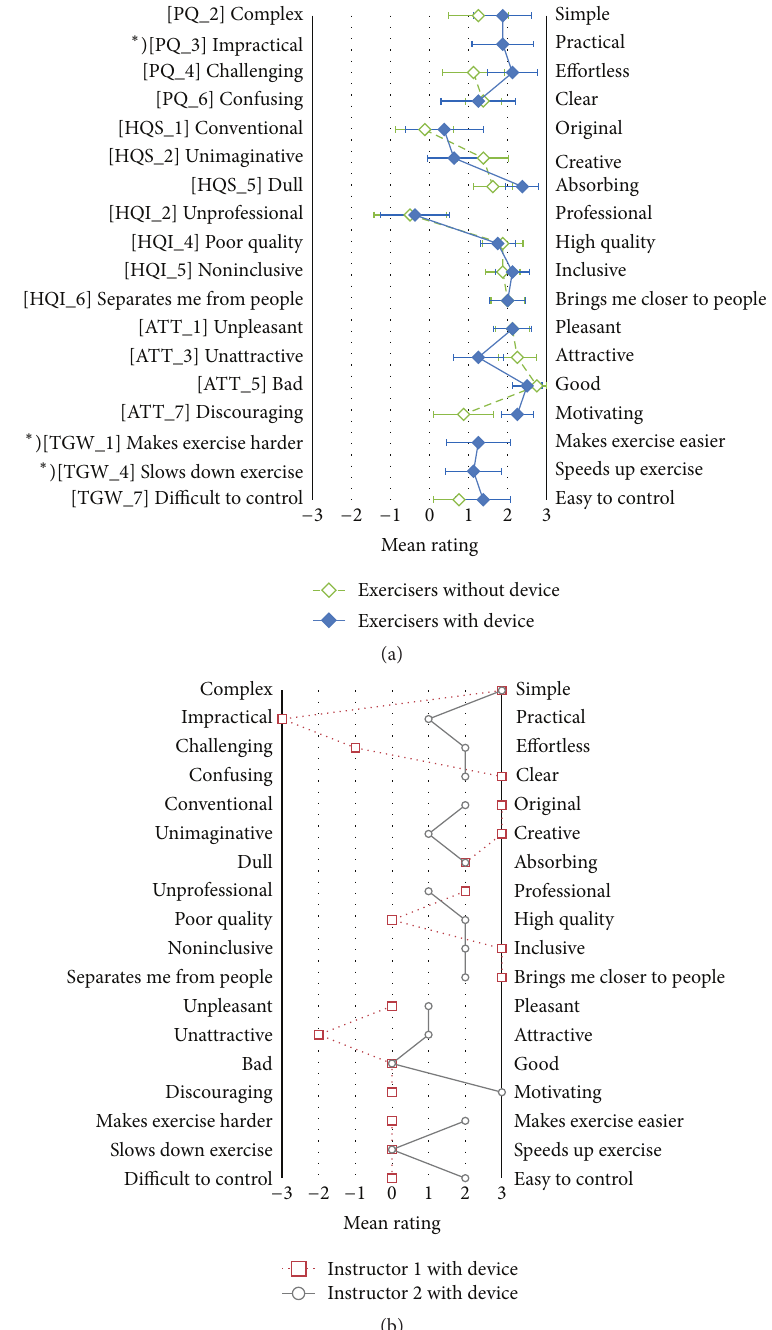
Figure 6: Mean ratings for the UX questionnaires on 7-point semantic differential scale given by (a) the exercisers and (b) the instructors. Items labeled with ∗ ) in (a) were excluded from the “exercise without the device” questionnaire. Error bars in (a) represent